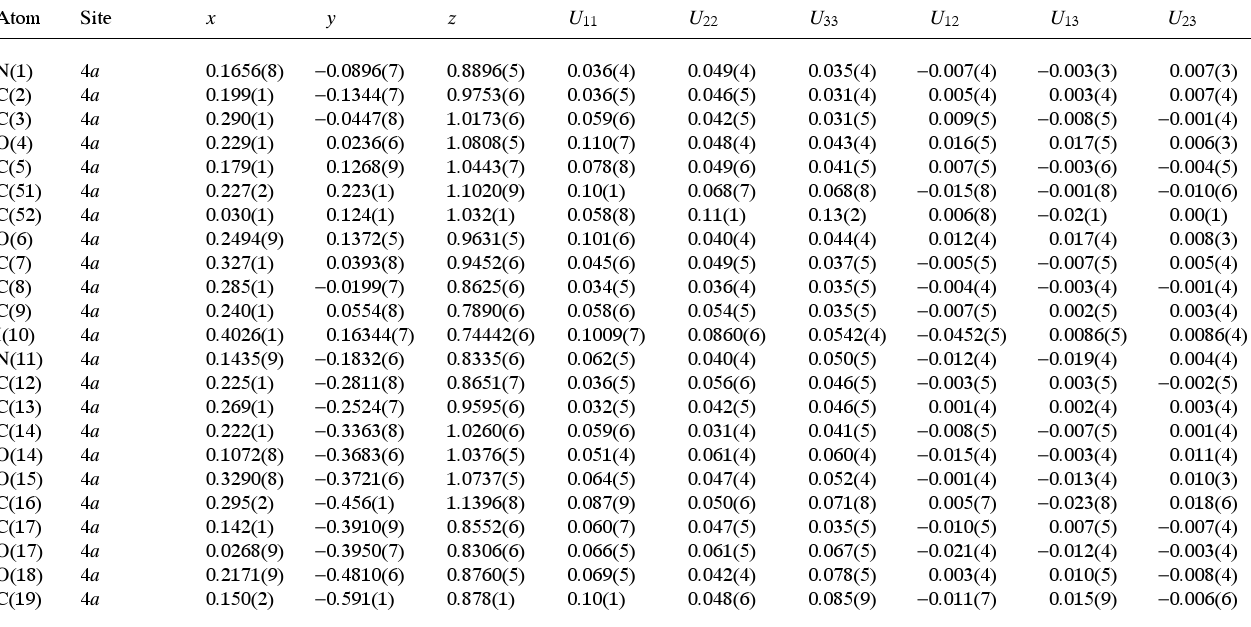
Table 3. A tomic coordin a tes a nd displ a cement p a r a meters (in Å 2 ) .